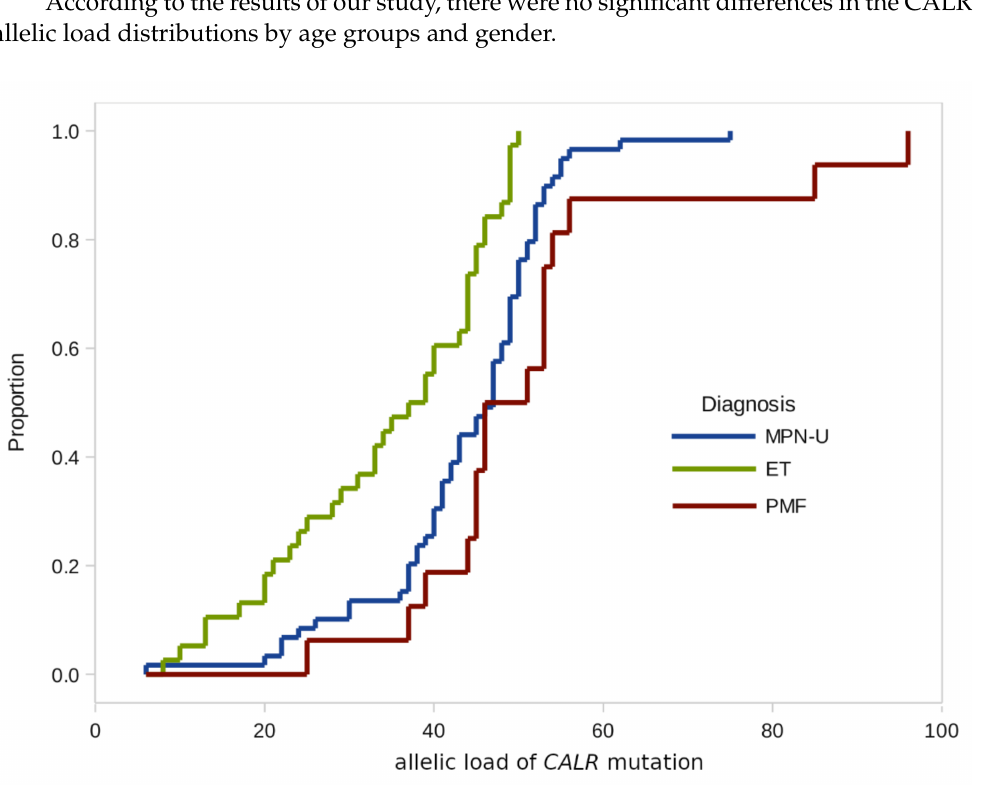
Figure 1. Empirical distributions of CALR mutation burden in patients with different